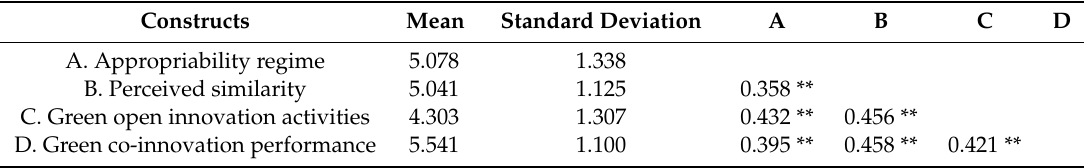
Table 3. Means, standard deviations, and correlations of the